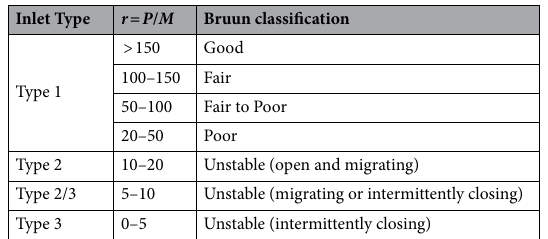
Table 1. Classification scheme for inlet Type and stability conditions (Reproduced from Duong et al. 13 , all rights